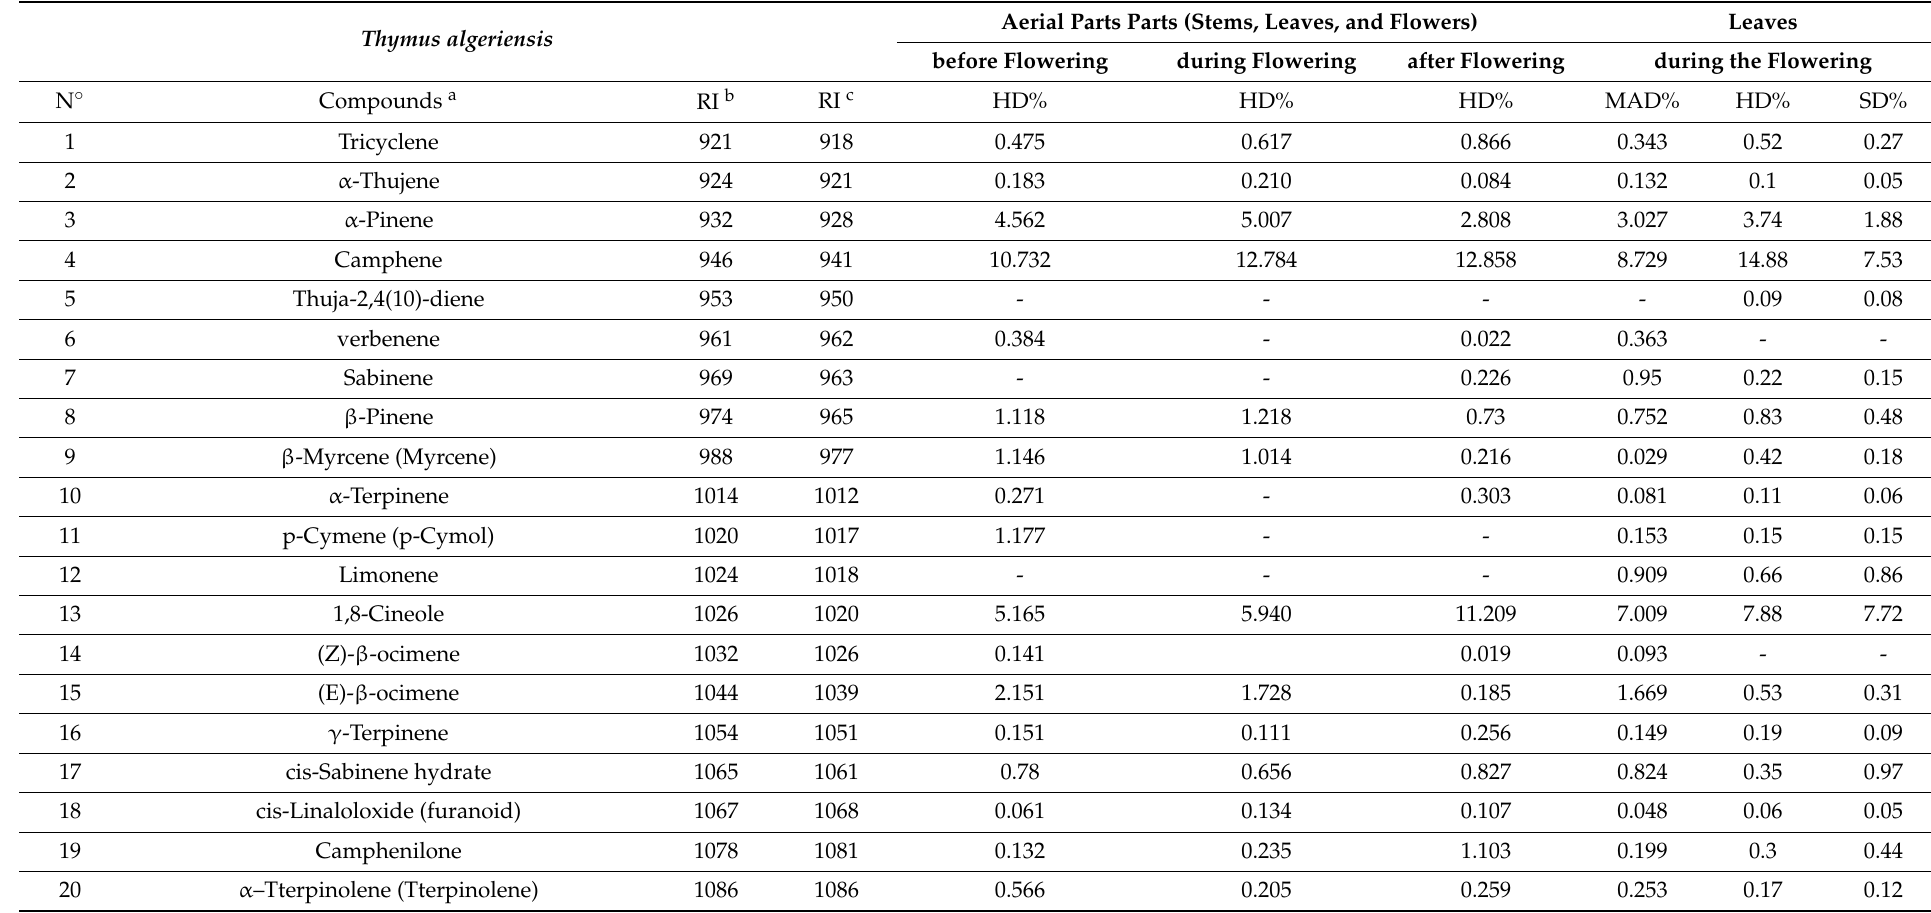
Table 1. The chemical composition of essential oil Thymus algeriensis (aerial parts and leaves samples), where RI represents the retention index. Aerial Parts Parts (Stems, Leaves, and Flowers) Leaves Thymus algeriensis before Flowering during Flowering after Flowering during the